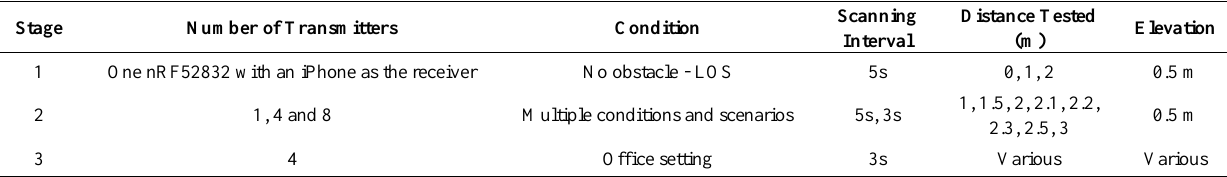
Figure 7. Stage 2 Experimentation Set Up Table 2. Summary of Experimentations Set Up for Three Stages